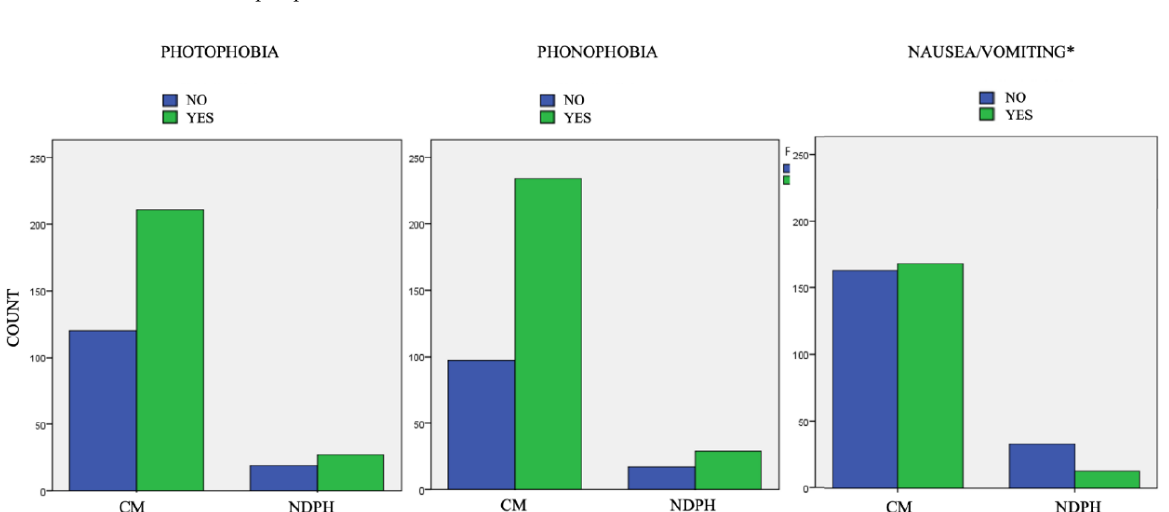
Figure 3. Associated symptoms in patients with new daily persistent headache (NDPH) vs. chronic migraine (CM). * p < 0.01.